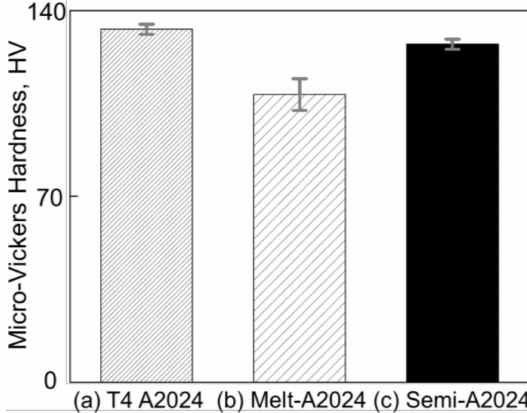
Figure 7. Micro-Vickers hardness. ( a ) T4-treated A2024; ( b ) cell walls of Melt-A2024; ( c ) cell walls of Semi-A2024. The error bars show the standard deviations.